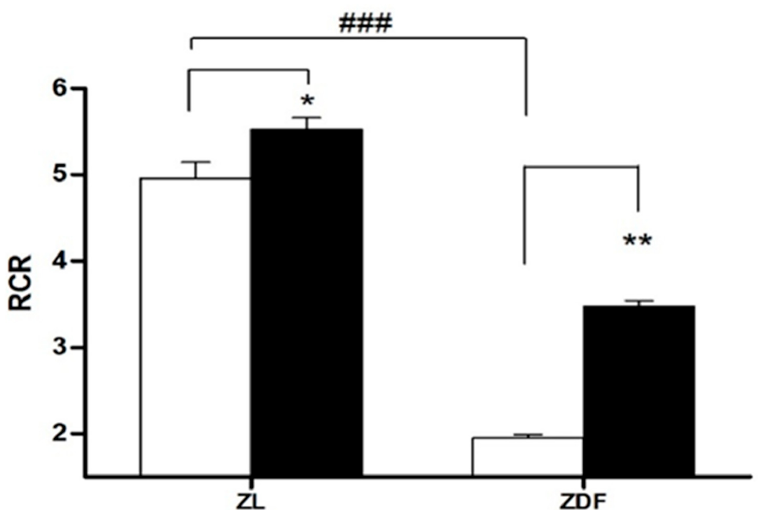
Figure 3. Respiratory control ratio (RCR) in isolated mitochondria from renal tissue. RCR is defined as the ratio state 3 / state 4. Values are the means ± S.E.M. ZL, Zücker lean rats; ZDF, Zücker diabetic fatty rats. Superscript letters refer to significant di ff erence measured using two-way ANOVA (* p < 0.05, ** p < 0.001 M-ZDF compared with C-ZDF, and M-ZL compared with C-ZL rats; ### p < 0.01 C-ZDF compared with C-ZL